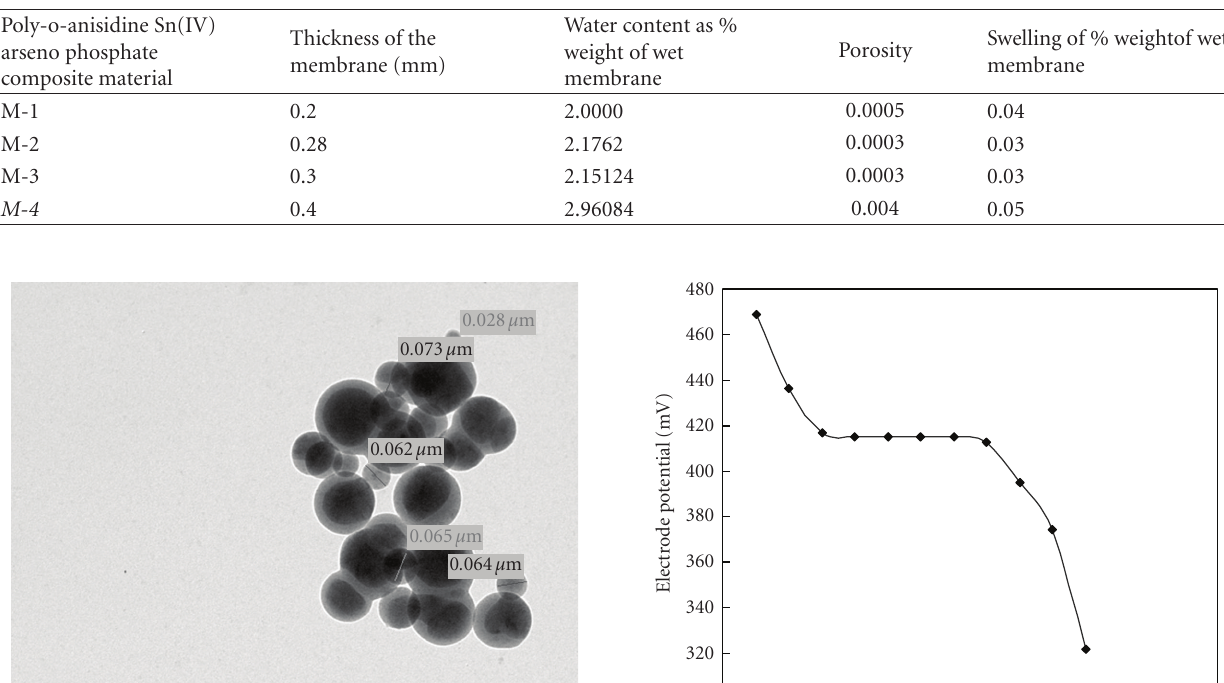
Table 4: Characterization of ion exchange membranes of poly-o-anisidine Sn(IV) arsenophosphate.